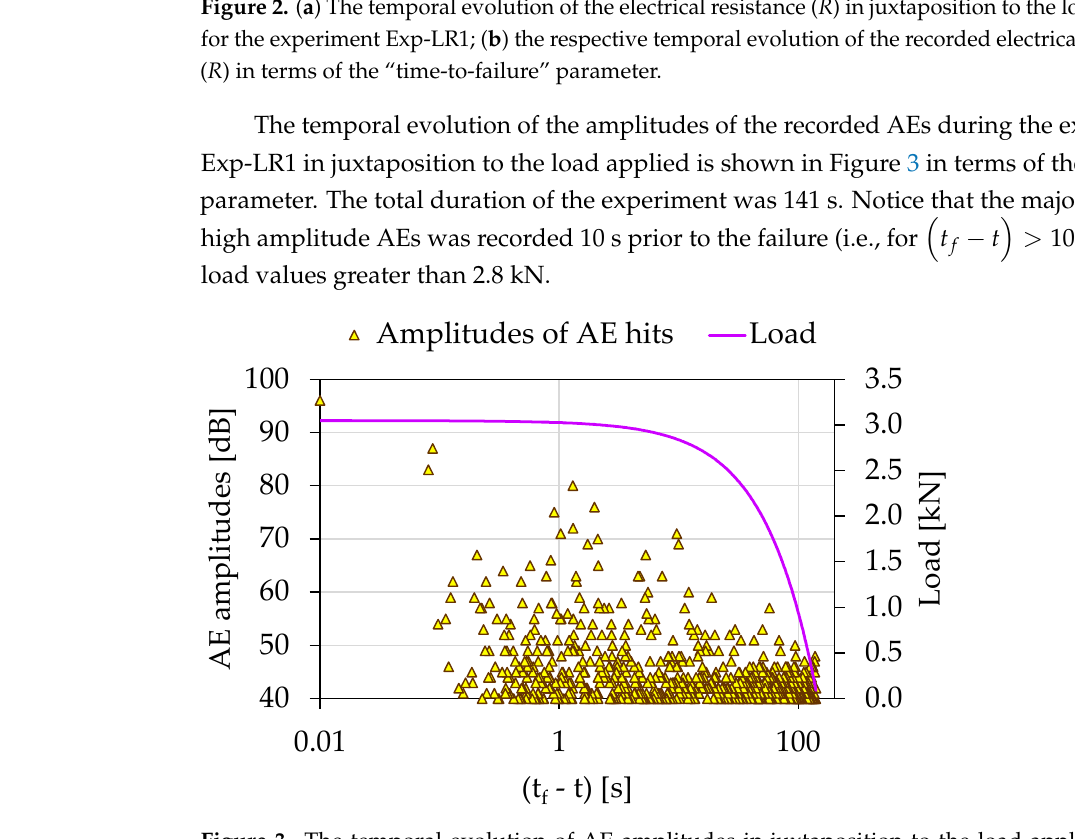
Figure 3. The temporal evolution of AE amplitudes in juxtaposition to the load applied for the experiment Exp-LR01 in terms of the “time-to-failure” parameter.